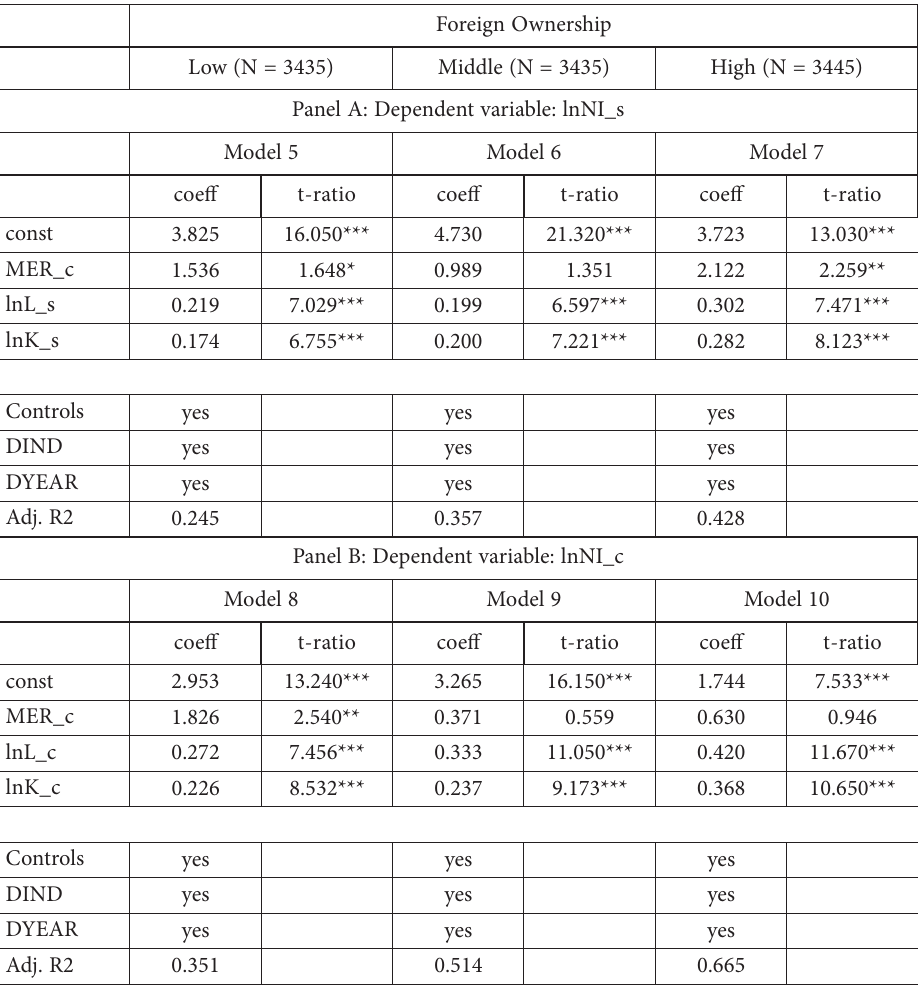
Table 5. Foreign ownership and profit